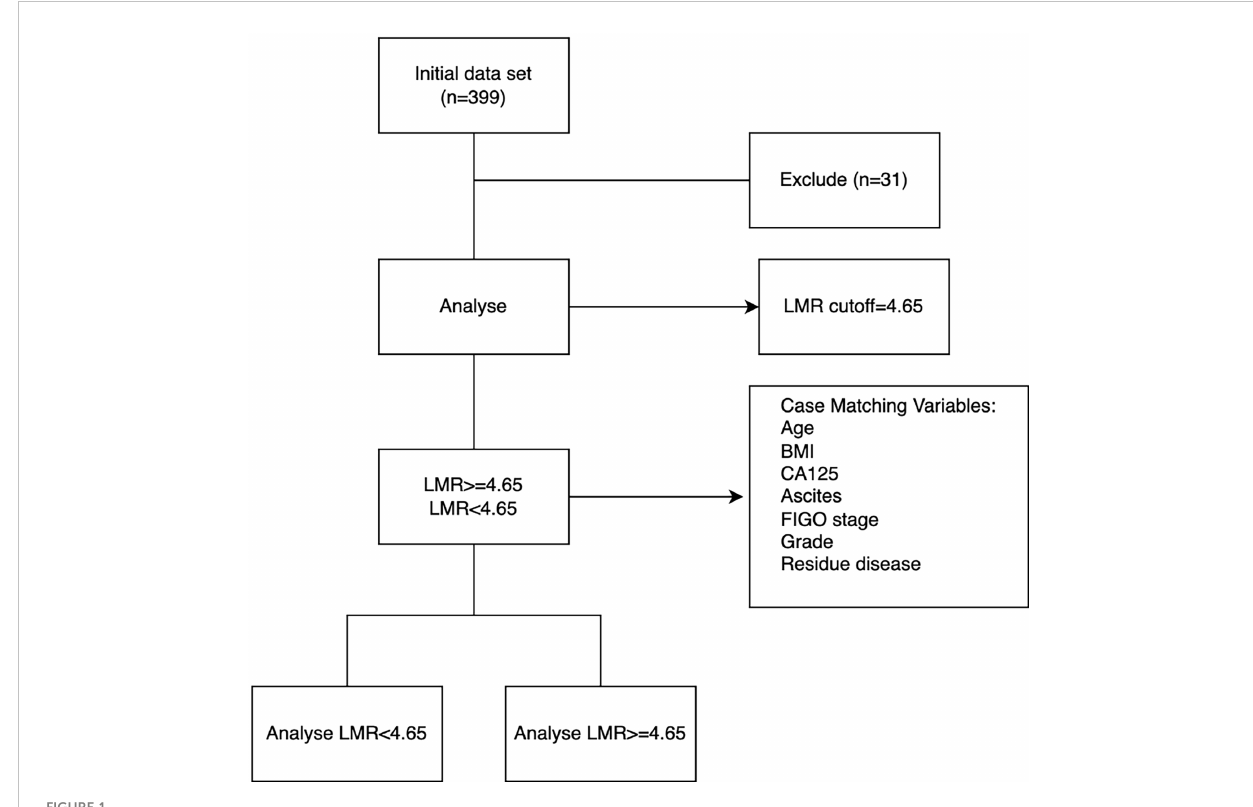
FIGURE 1 Flowchart of the study